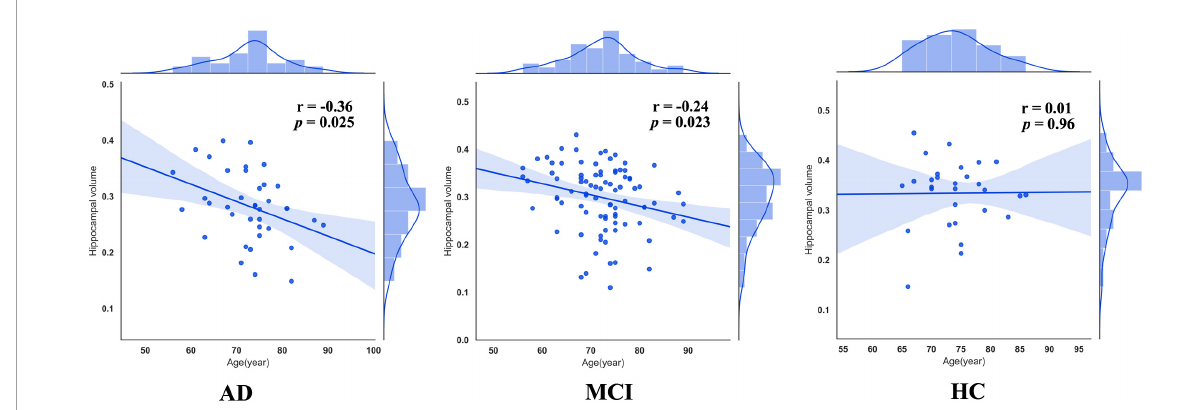
FIGURE3 Correlations between right hippocampus in three groups.